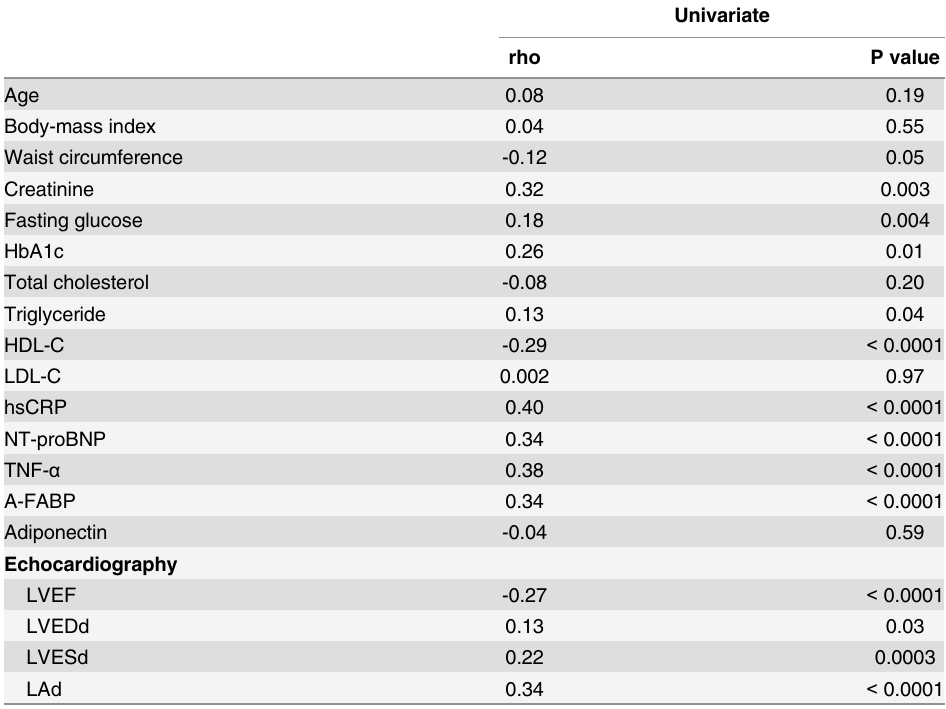
Table 2. Spearman correlation of ANGPTL2 levels with cardiovascular risk